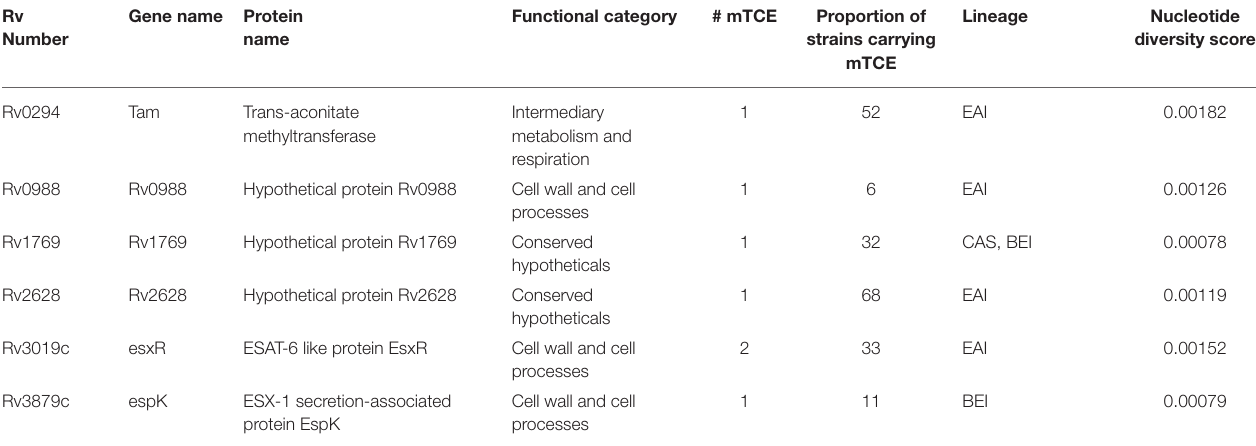
TABLE 1 | List of known T-cell antigens carrying mutated epitopes present in the top 10% of rapidly evolving genes of 79 Mtb strains isolated in India. Rv